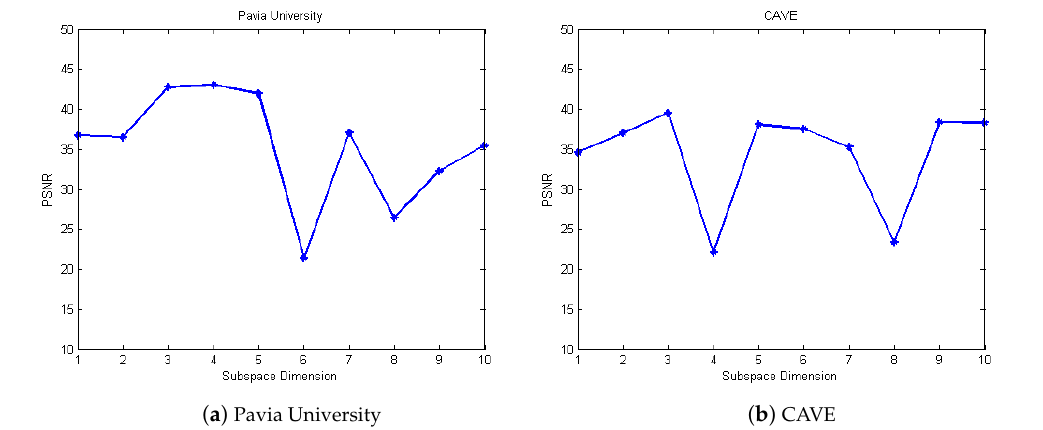
Figure 2. FSF fusion quality on two datasets with different number of